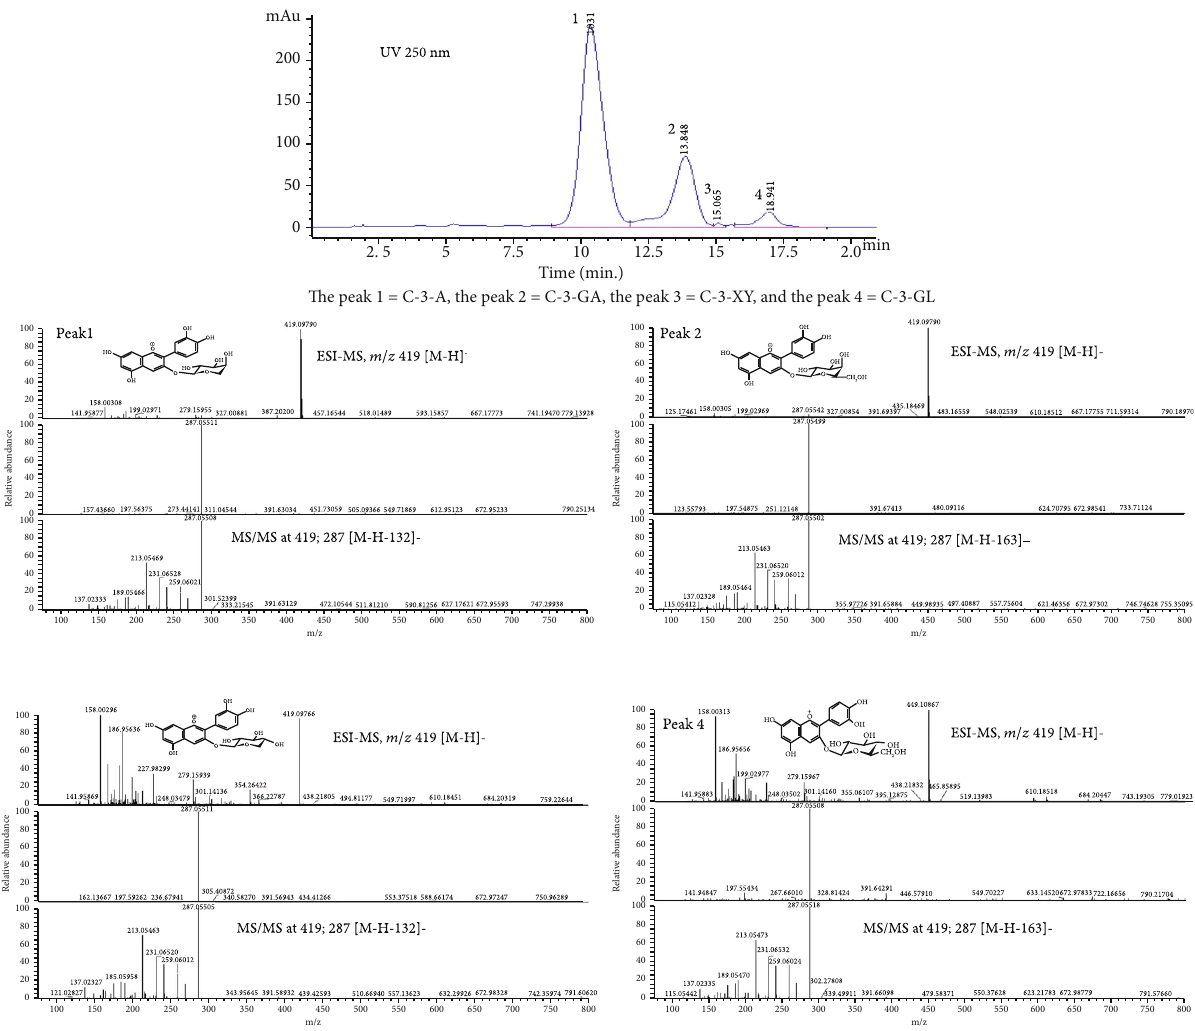
Figure 1: Chromatogram representing the peaks of anthocyanins and the MS/MS analyses of anthocyanin